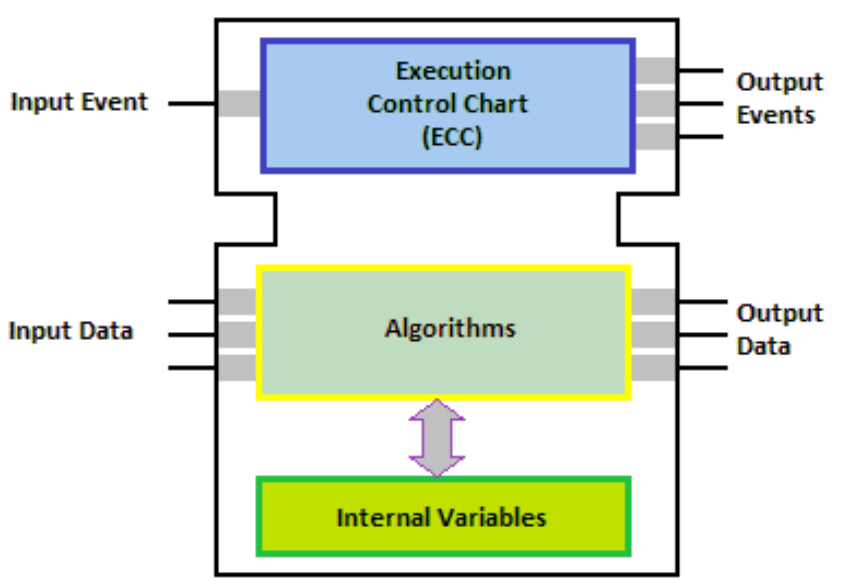
Figure 1. IEC 61499 function